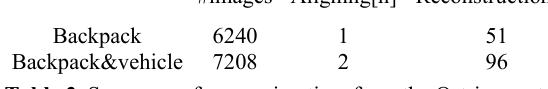
Table 3. Summary of processing time from the Ostring part To process the data, we used a workstation with two 20 Cores CPUs, 512 GB RAM and two Nvidia GeForce 2080 Super.